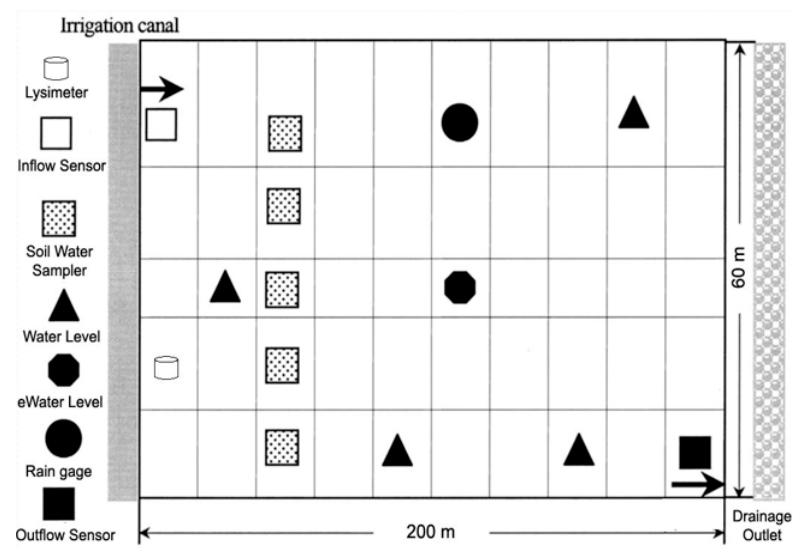
Figure 1. Layout of the equipment installation for the field investigation of water balance components in a paddy field.